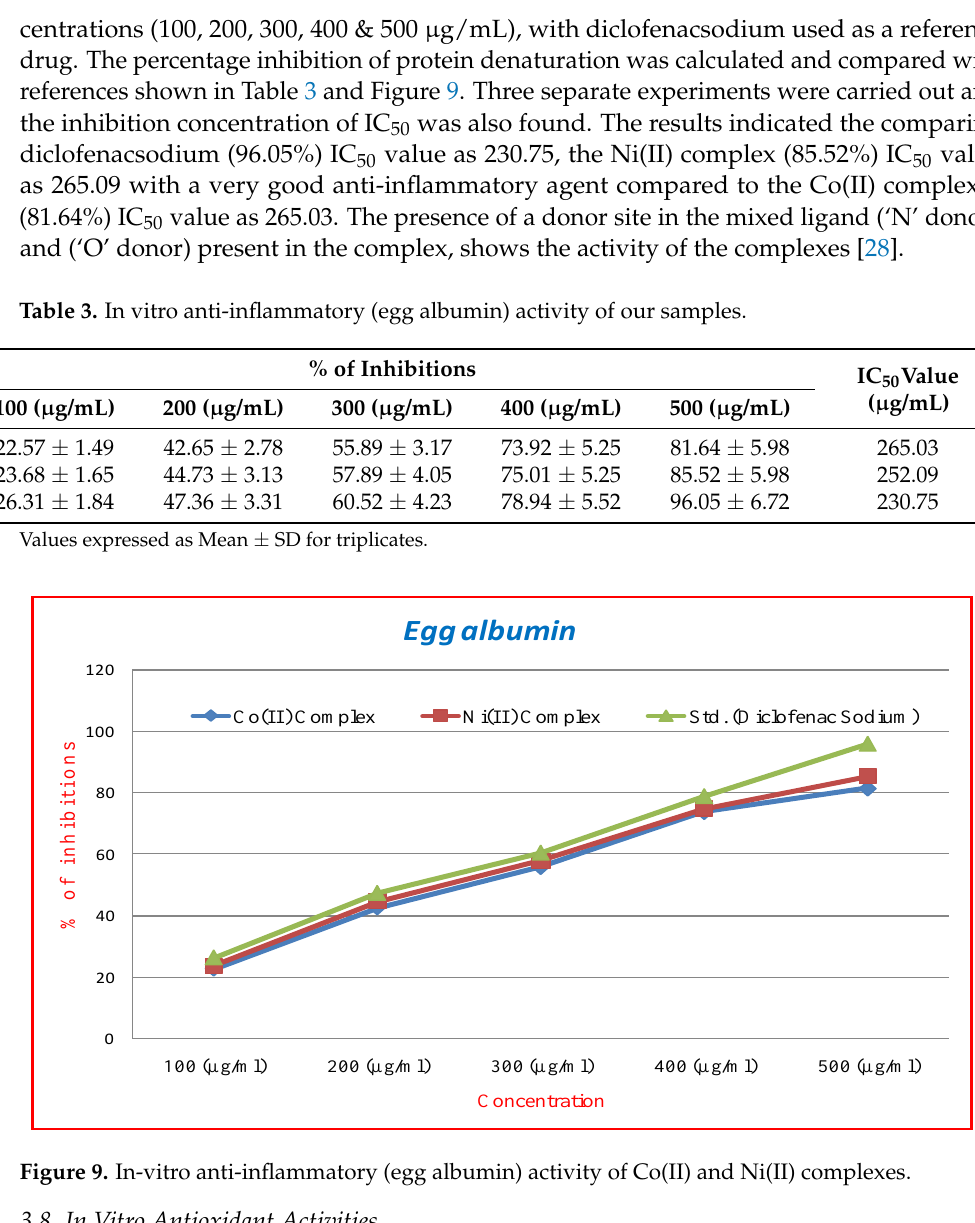
Table 4. In vitro antioxidant (DPPH) activity of metal complexes.